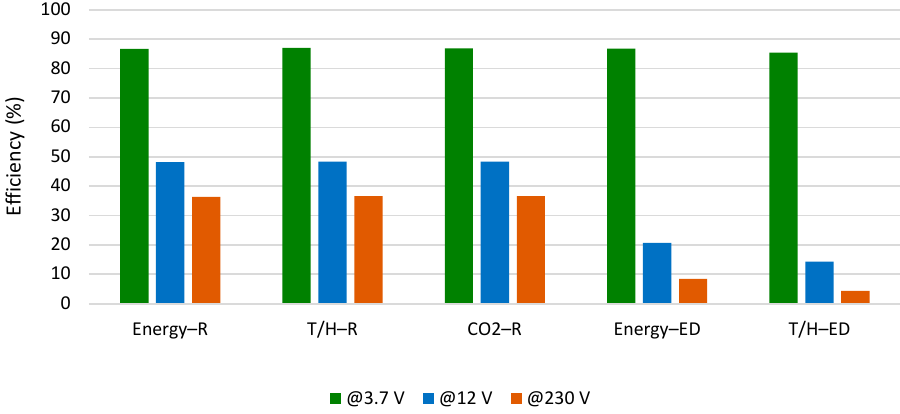
Figure 7. Efficiencies obtained for sensor nodes with different energy sources.